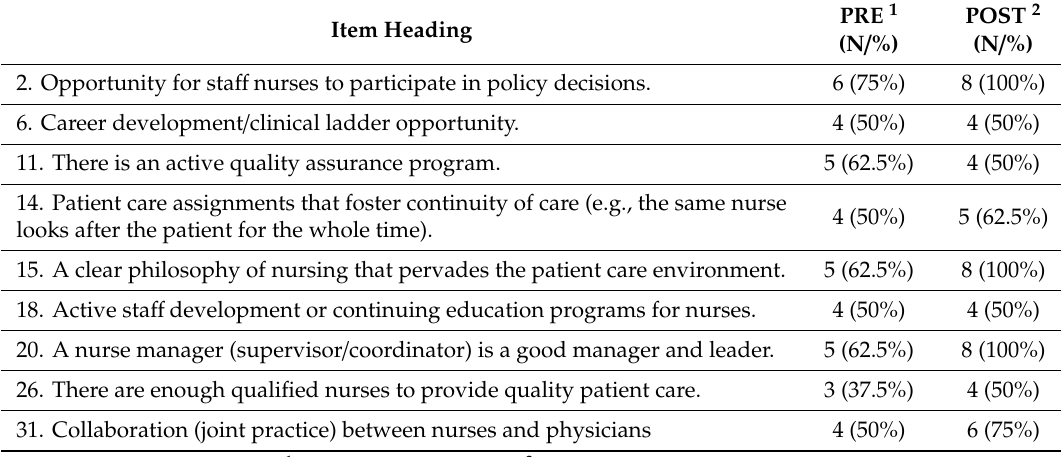
Table 3. Main items with the experts’ count stage results, pre and post the focus